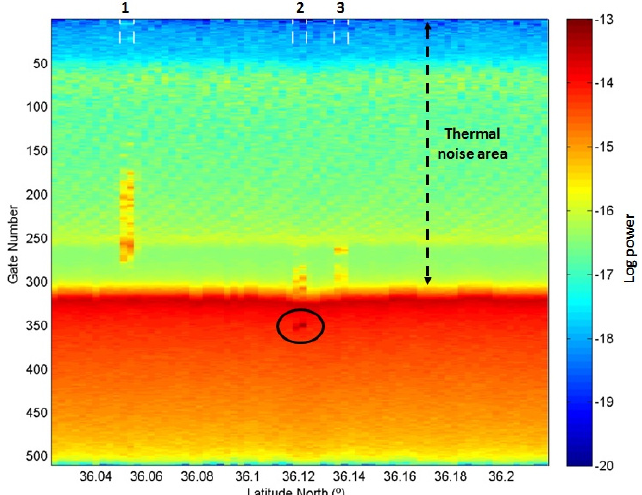
Figure 2. Radargram of the 73 CryoSat-2 SIRAL SAR waveforms along the track segment analyzed (Figure 1c) in log10 scale. The dashed white lines delimit the waveforms with visible anomalies in the thermal noise and trailing edge areas. The black circle indicates the position of the power peaks corresponding to the off-nadir scatterer in structure 2.